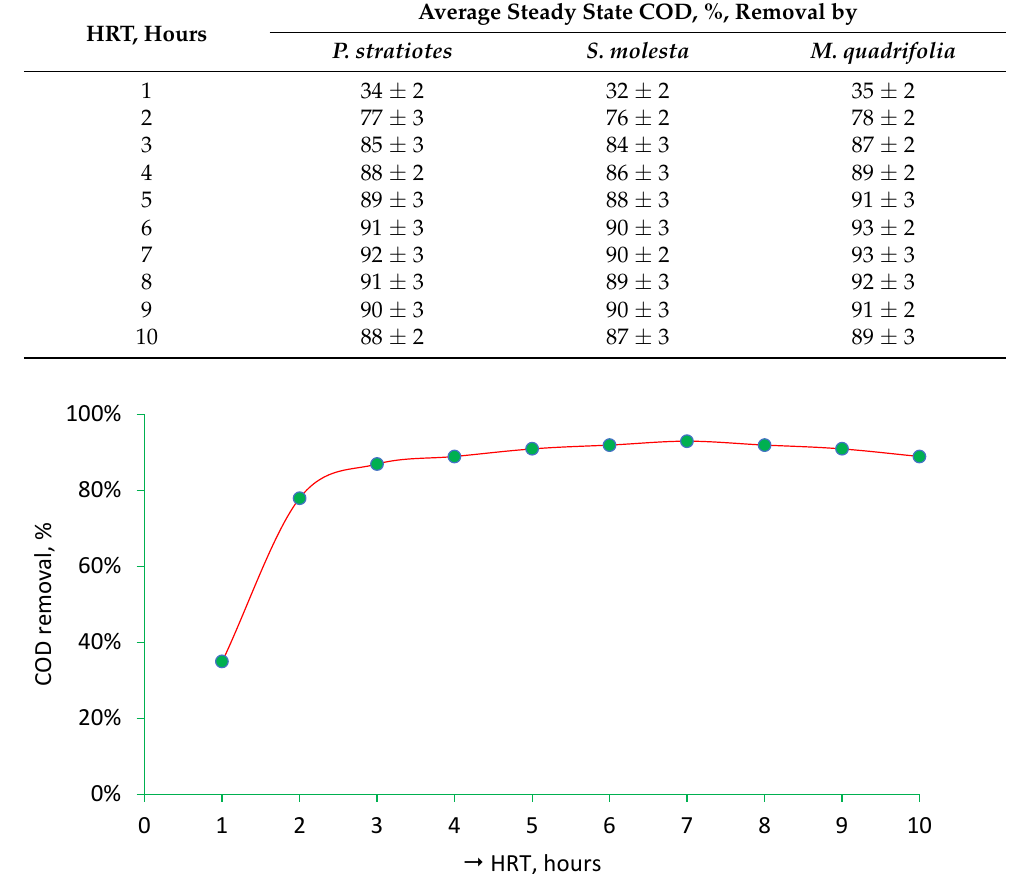
Figure 4. Average COD removal at different HRTs in SHEFROL channels stocked with M. quadrifolia , after steady state had been reached.